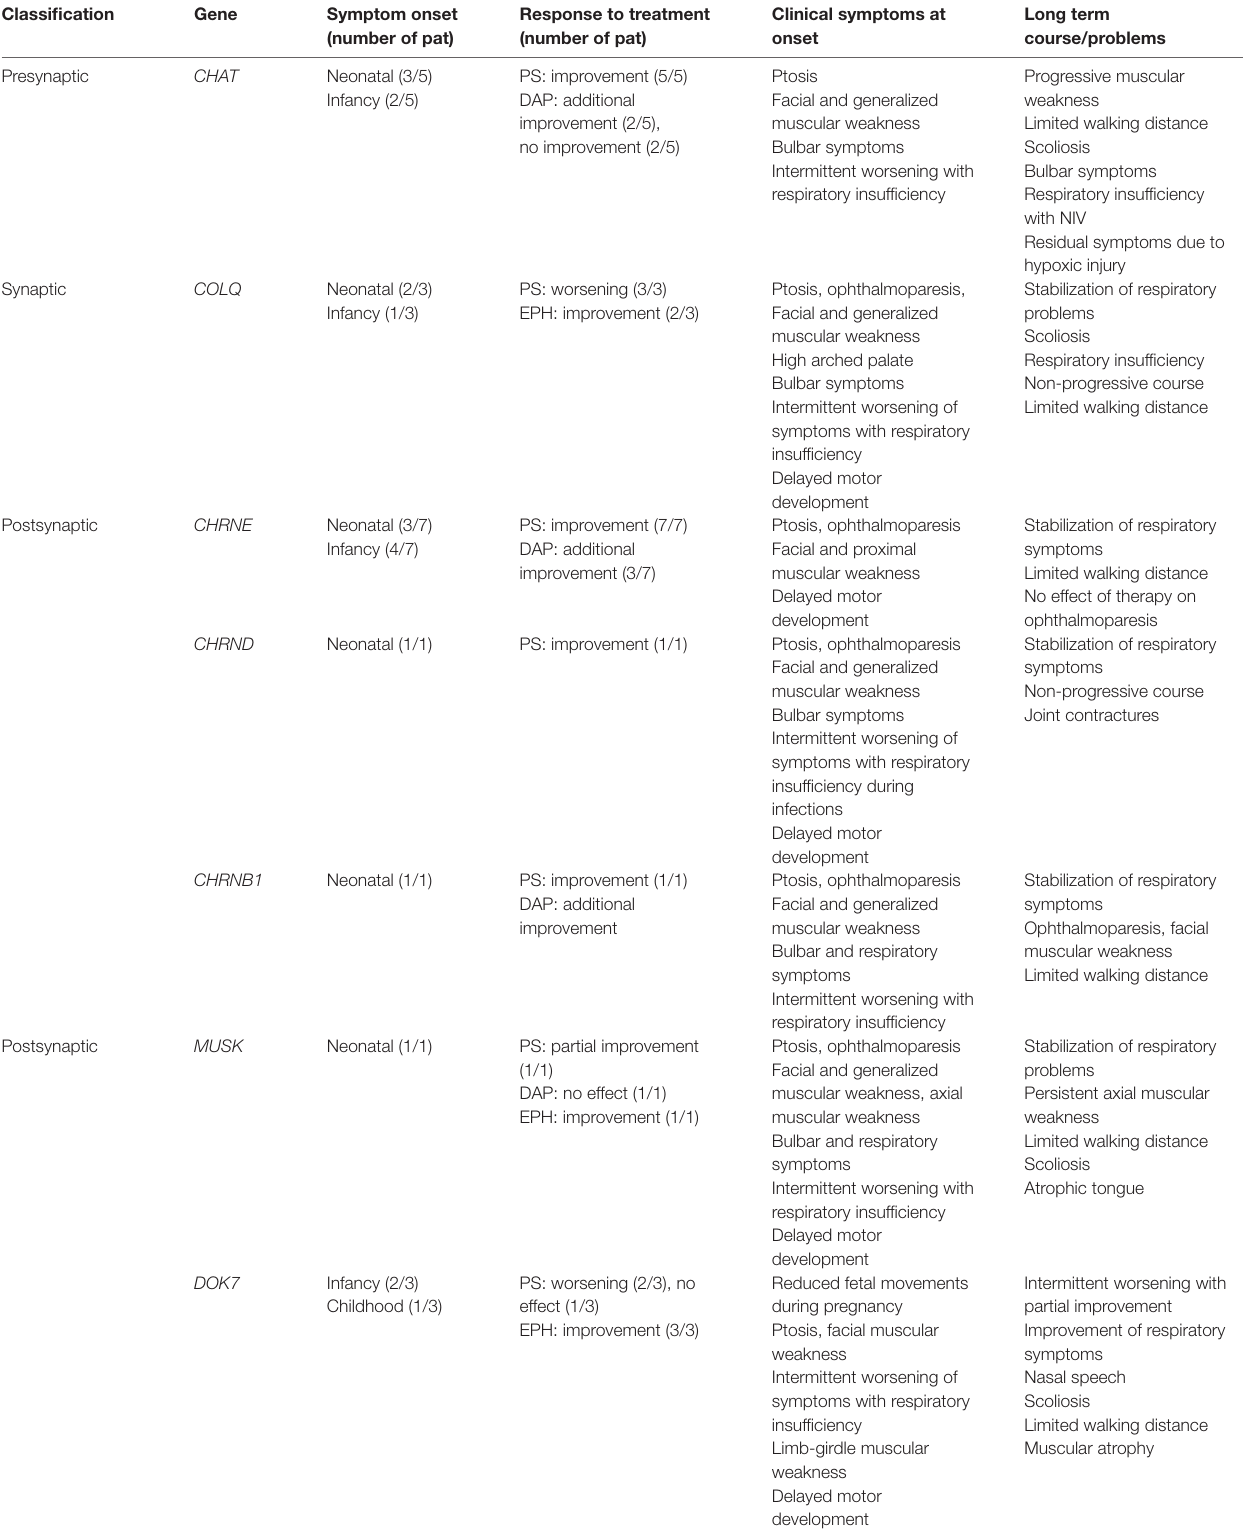
TABLE 1 | Response to therapy, symptoms at onset, and long term course in patients according to the NMJ-localization of the protein affected by the respective mutation.